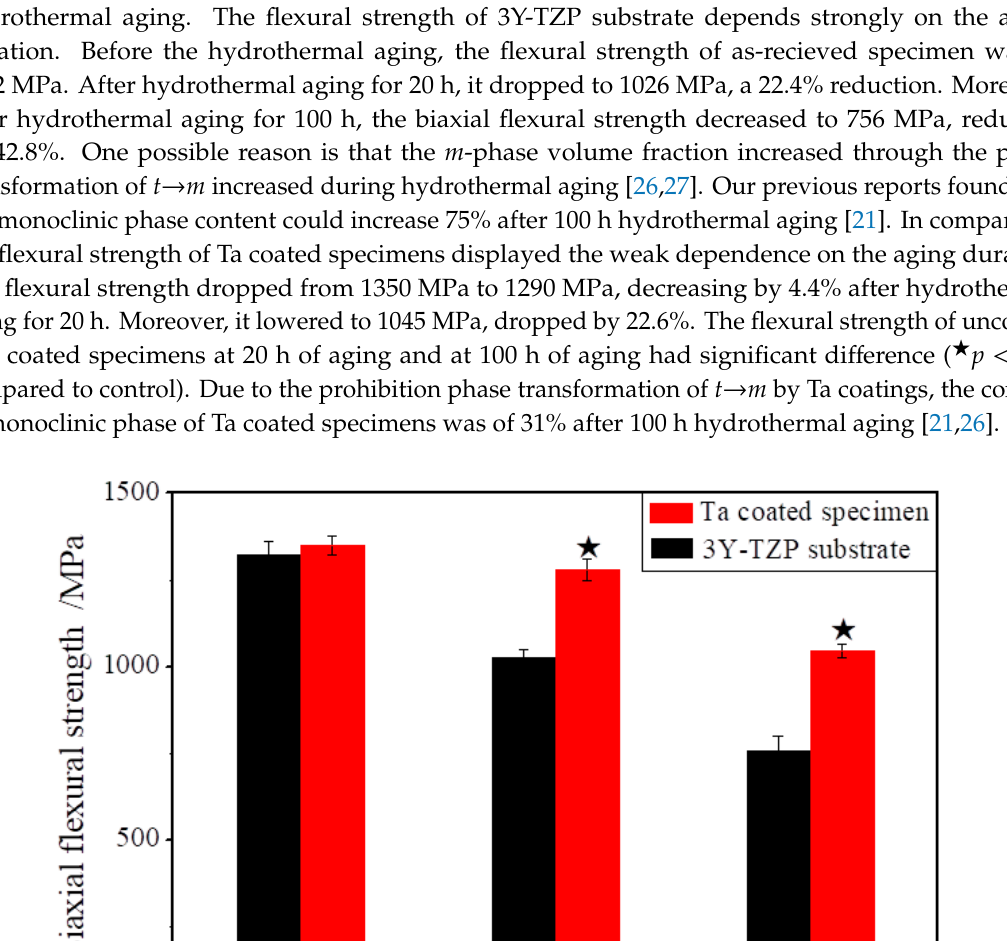
20 h and 100 h, (cid:70) p < 0.05 compared to 20 h and 100 h, ＊ p < 0.05 compared to control.